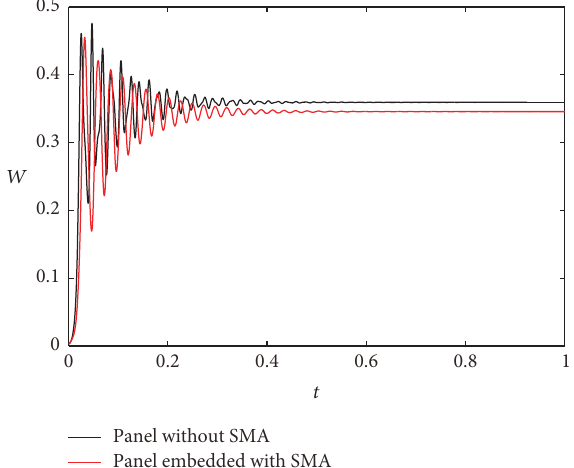
Figure 12: Time history for 𝜆 = 20 and Δ𝑇 = 1.4Δ𝑇 cr